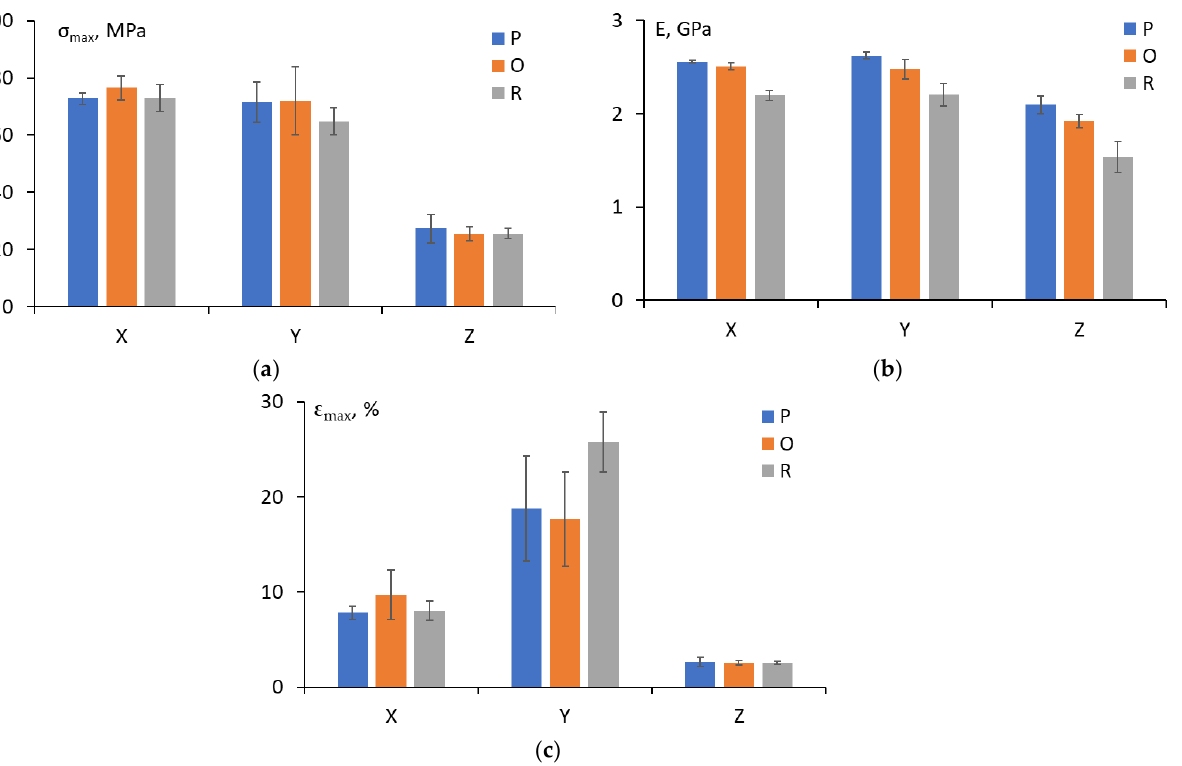
Figure 6. Tensile strength ( a ), elastic modulus ( b ), and maximal deformation ( c ) of Ultem in relation to printing direction (the cooling conditions are indicated on the graph as P, O, and R).